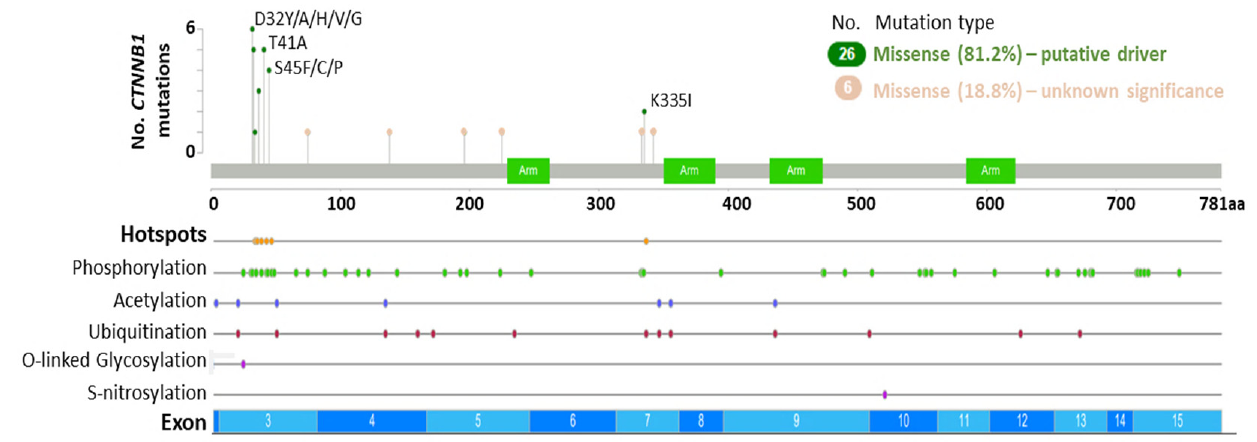
Figure 2. CTNNB1 somatic mutations in prostate cancer. Diagram indicates CTNNB1 mutation frequency in relation to exons and post-translational modifications. Data sourced from The Cancer Genome Atlas (TCGA) Firehose Legacy (primary: n = 492) [66] and the SUC2/PFC International Dream Team (metastatic: n = 444) [64] prostate adenocarcinoma datasets using cBioPortal [68,69] (Table S5). Germline mutations: 0/32 (0.0%). Somatic mutations: 30/32 (93.75%). Unknown mutational status: 2/32 (6.25%). Arm: Armadillo repeat.